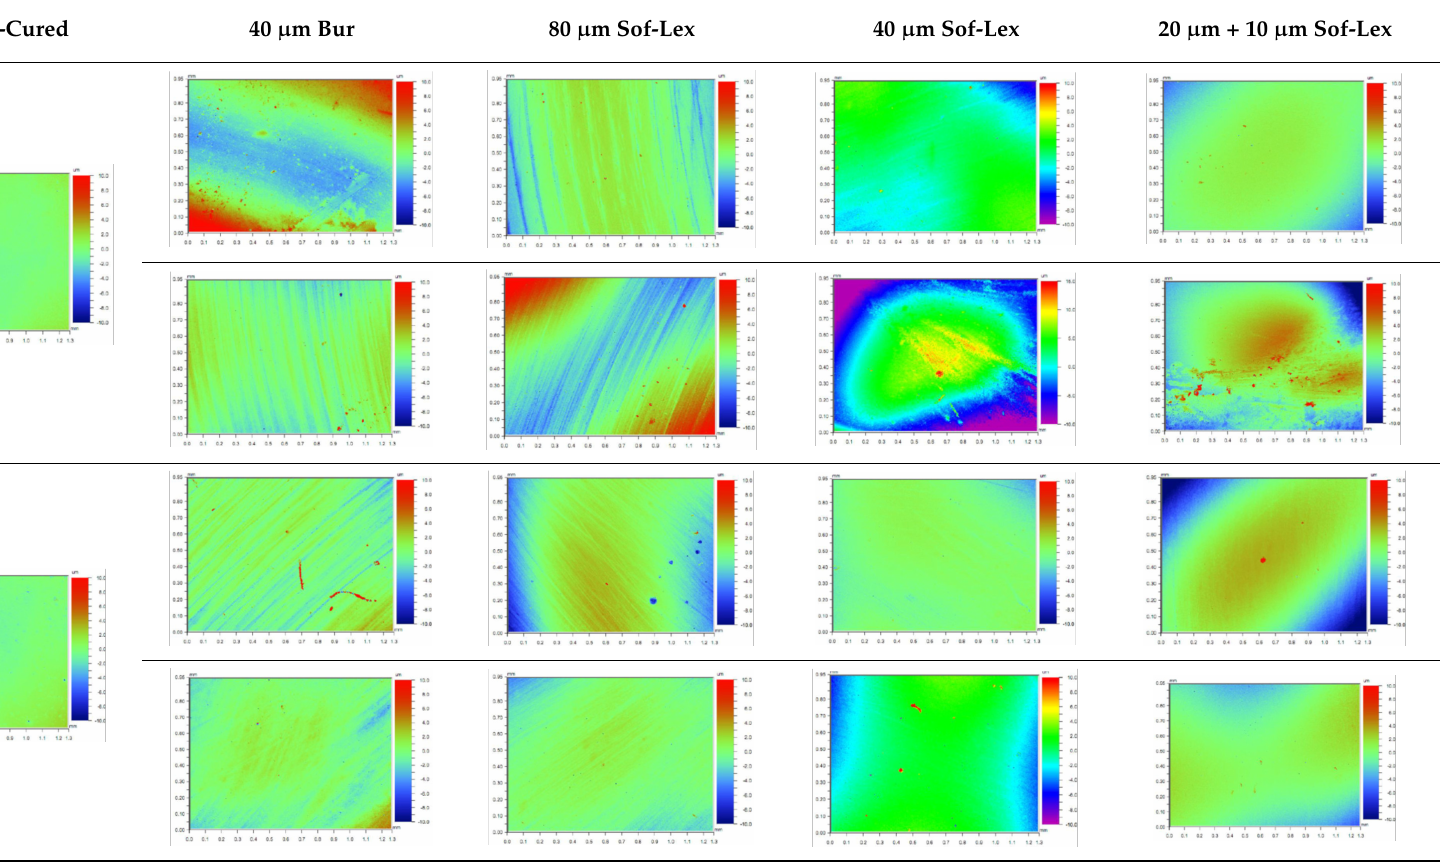
Table 2. Representative Figures for Optical Profilometry Analysis in the Individual Polishing Steps Depending on the Composite Resin and the Press-on Force. Composite